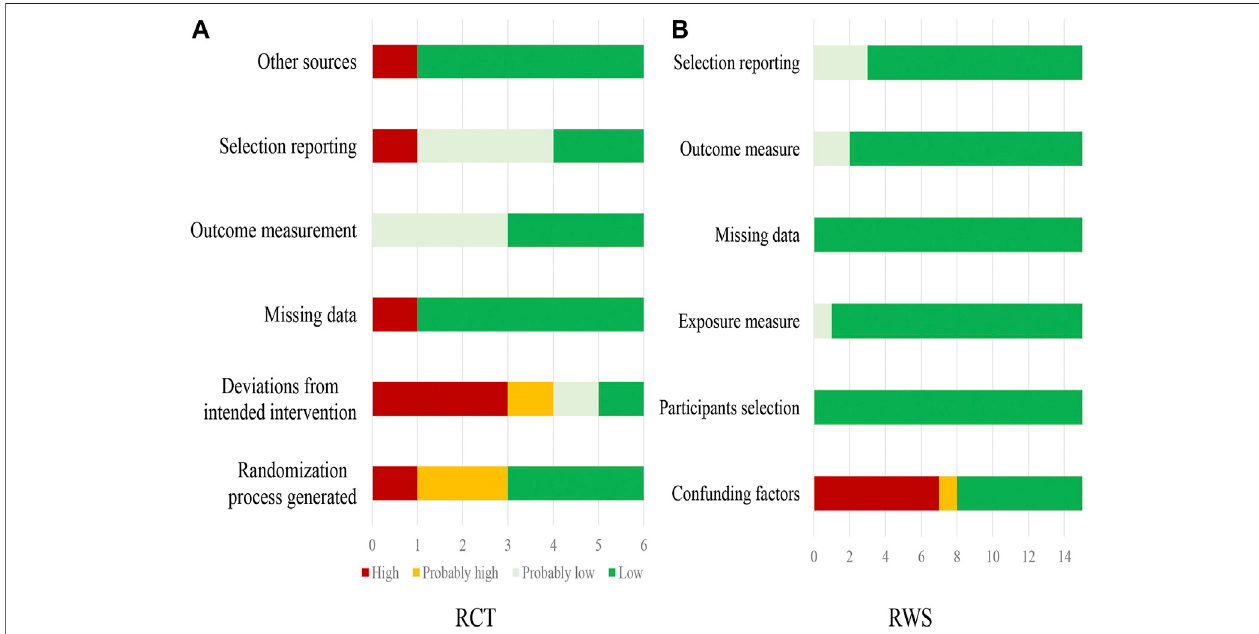
FIGURE 2 | Risk of bias of included RCTs (A) and observational studies (B)